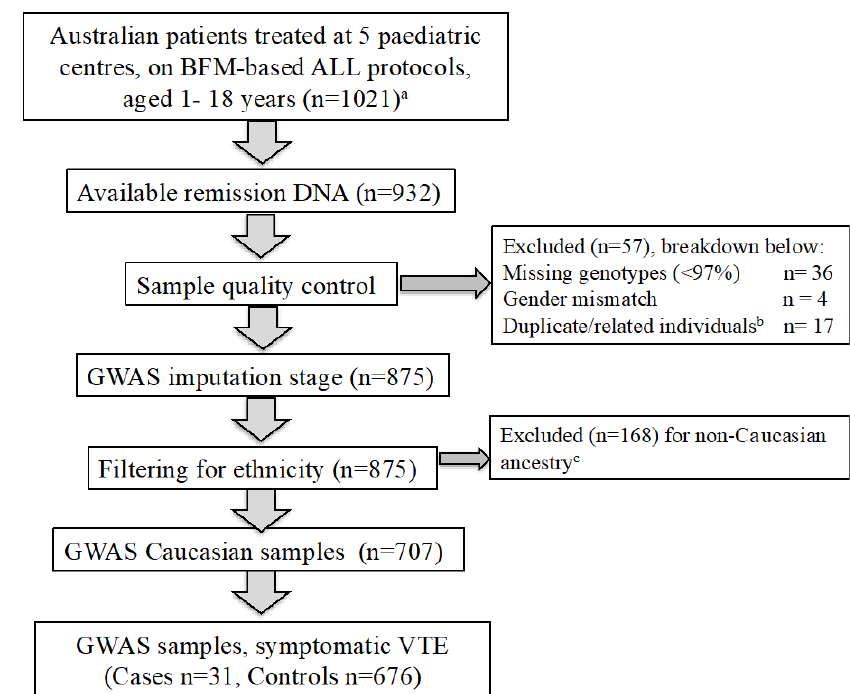
Figure 2. Consort diagram of 707 individuals in the Evaluation of Risk of ALL Treatment-related Side-E ff ects (ERASE) GWAS discovery cohort for symptomatic VTE. a ERASE clinical cohort described in Mateos, et al., 2019. b Pi-hat threshold > 0.2. c Non-Caucasian ancestry defined as per 1000 Genomes data. After quality control and filtering for ethnicity, there were 707 individuals of Caucasian ancestry in the ERASE GWAS analysis.